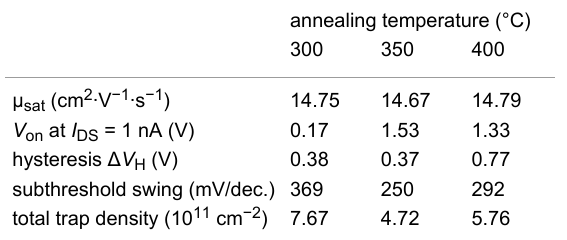
Table 1: The electrical parameters of a-IGZO TFTs annealed at differ- ent